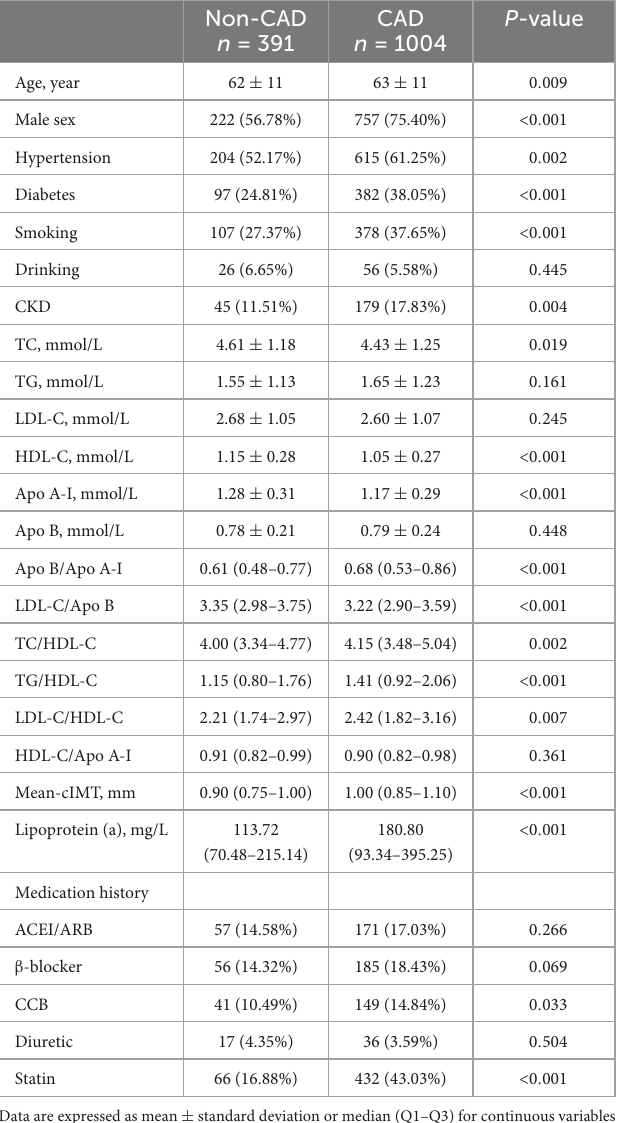
TABLE 1 Baseline information of CAD and non-CAD